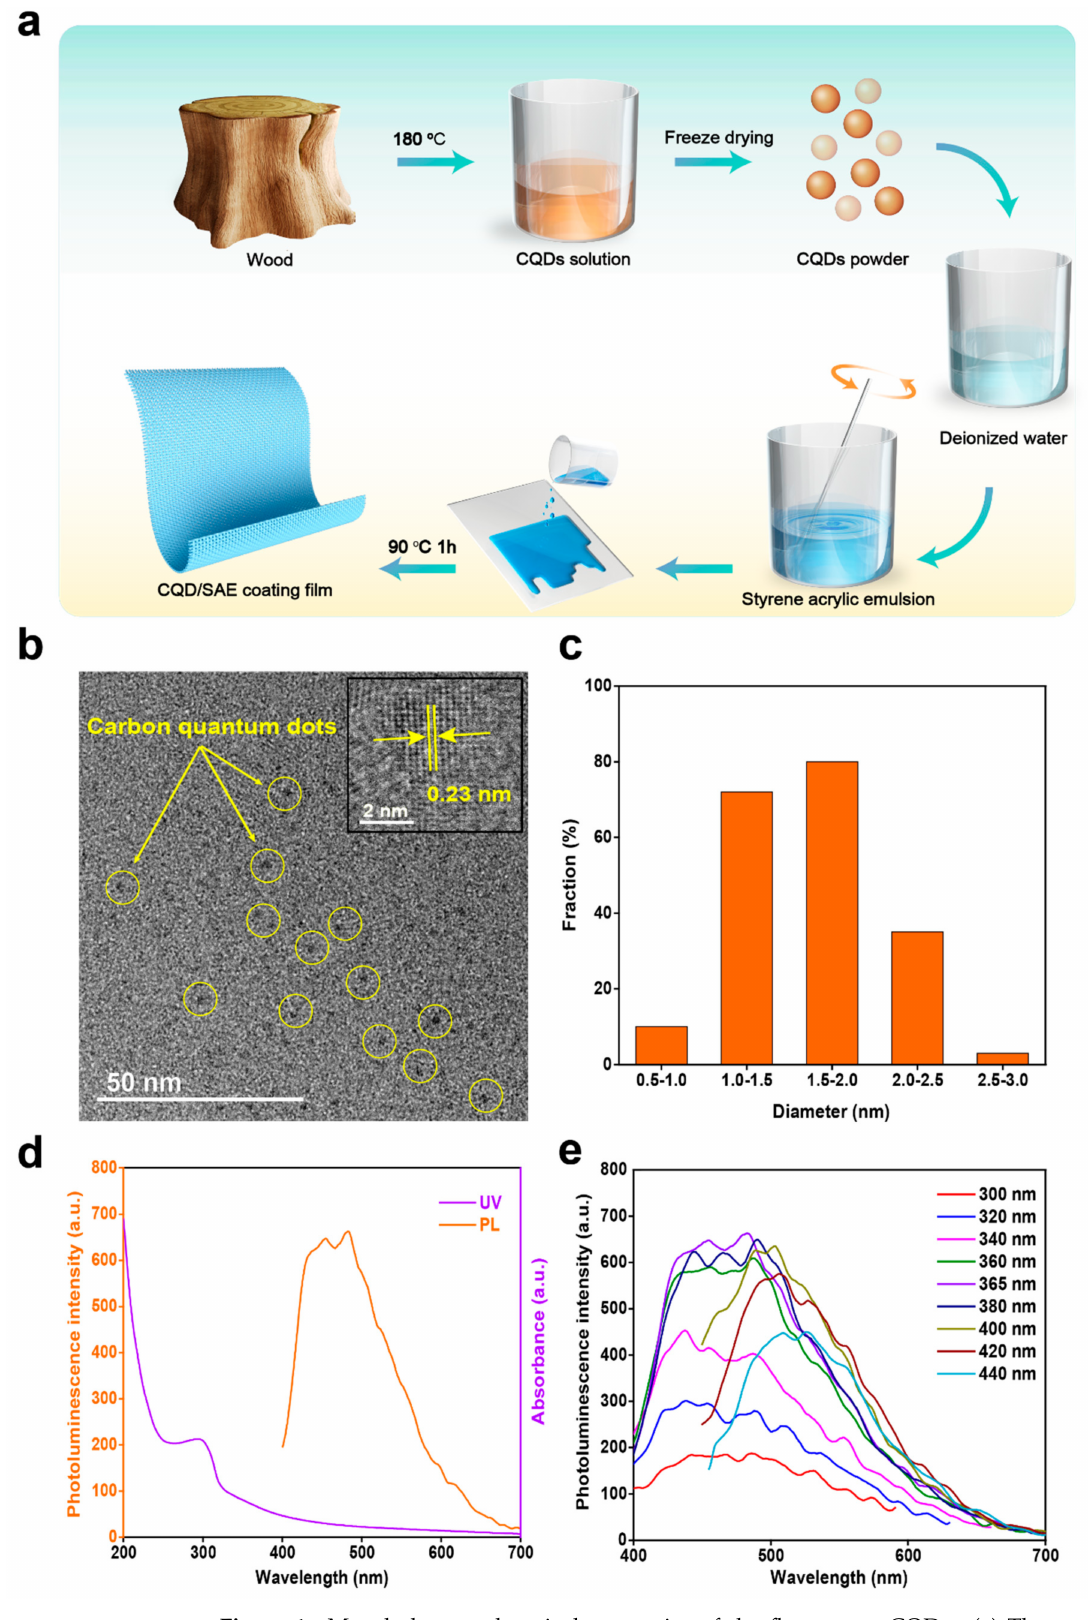
Figure 1. Morphology and optical properties of the fluorescent CQDs. ( a ) The preparation of CQD/SAE coating films. ( b ) TEM image of the CQDs. ( c ) Size distribution of the CQDs. ( d ) UV − vis absorption spectra and PL intensity spectra of the CQDs. ( e ) PL intensity spectra of the CQDs excited at various